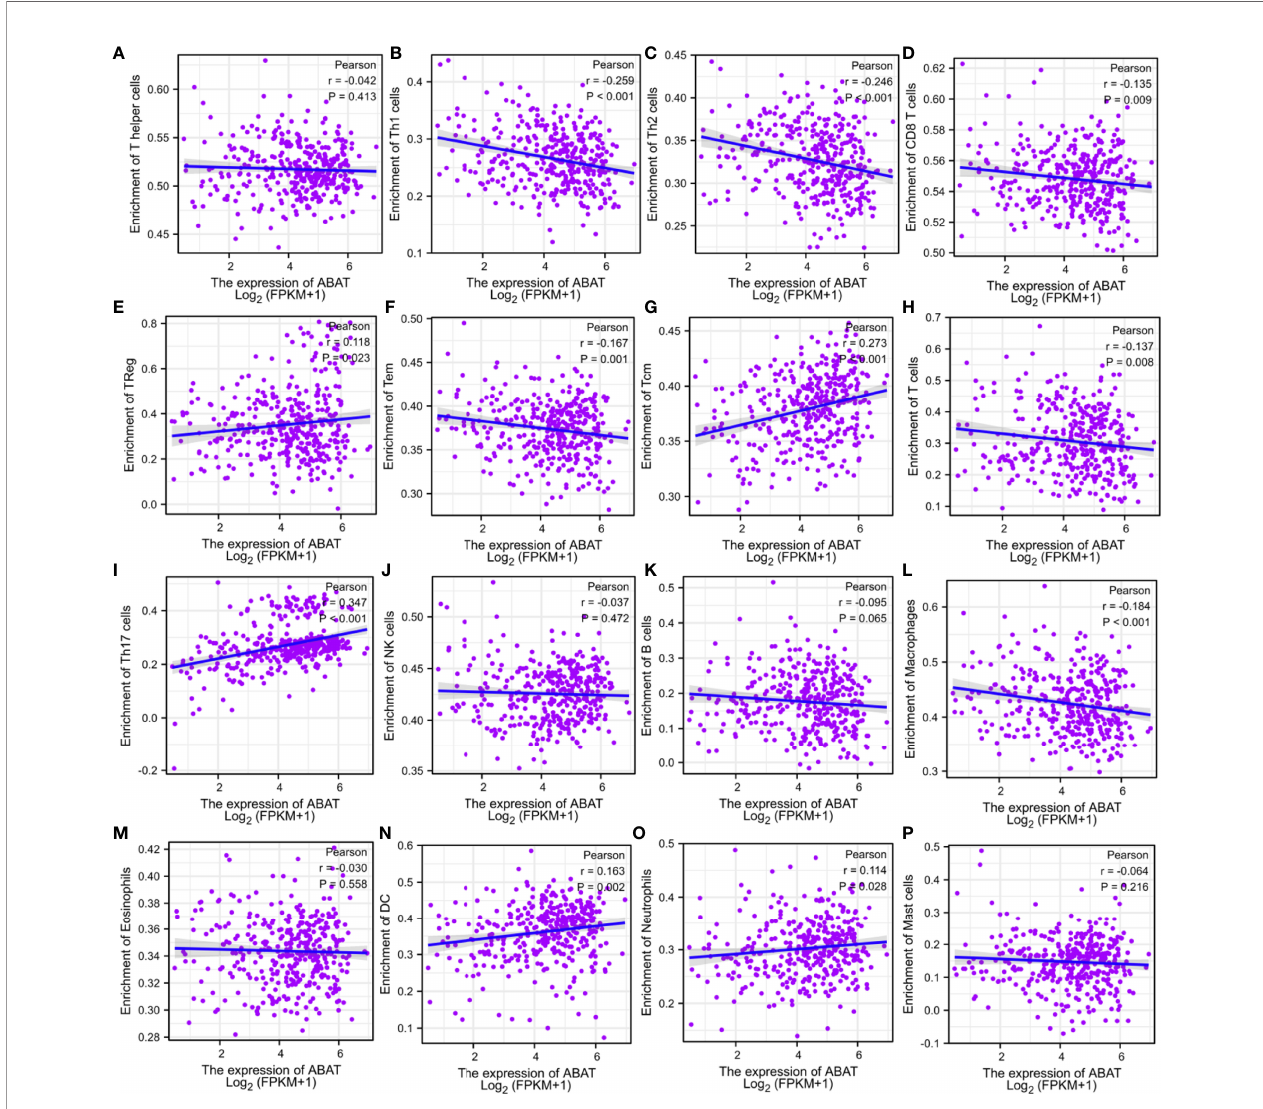
FIGURE 11 | (A – P) Relationship between ABAT expression and tumor in fi ltrating immune